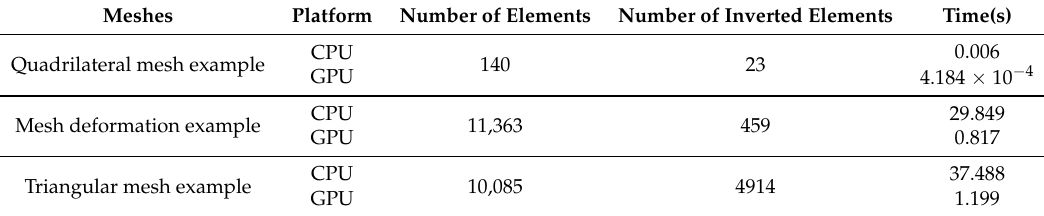
Table 5. Comparison of optimization results on CPU and